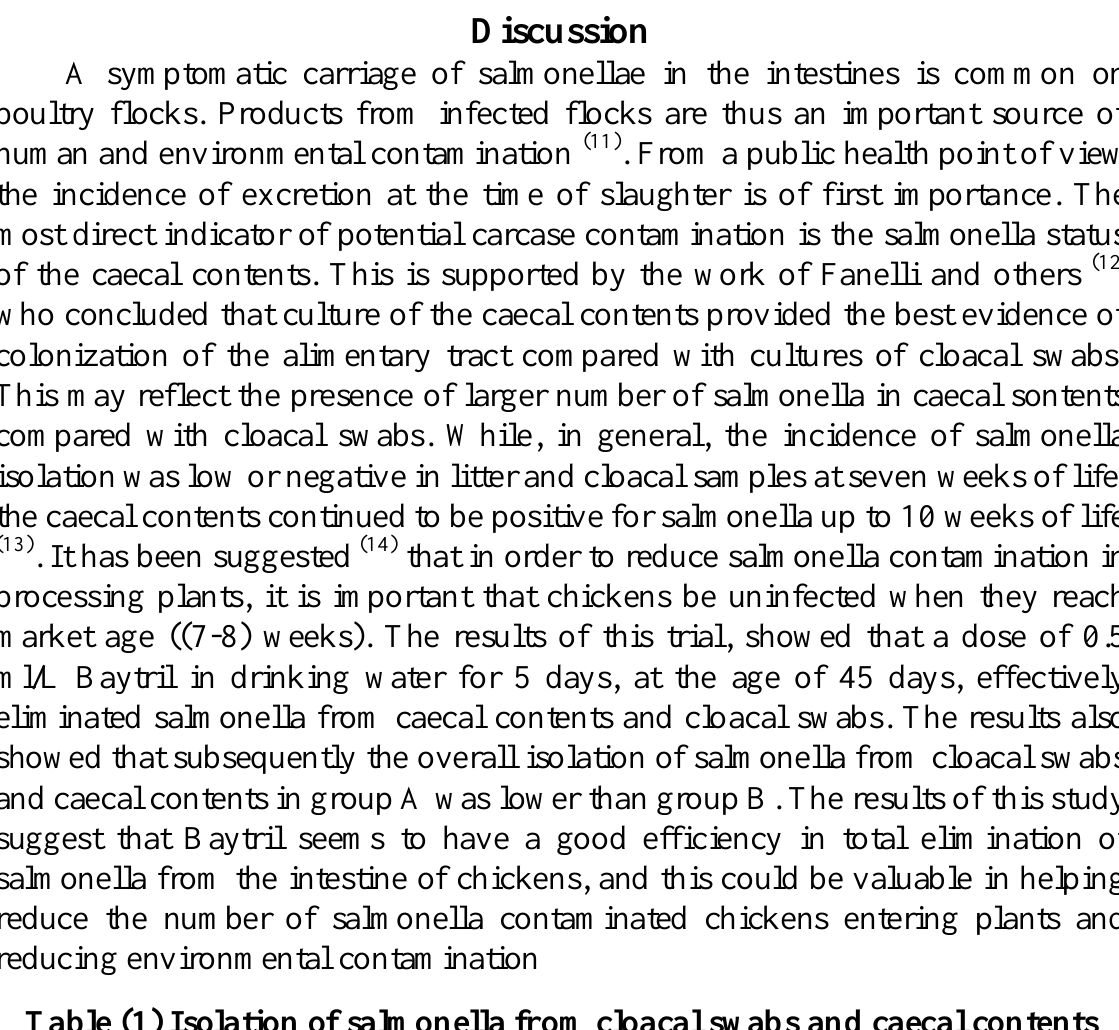
Table (1) Isolation of salmonella from cloacal swabs and caecal contents from groups A and